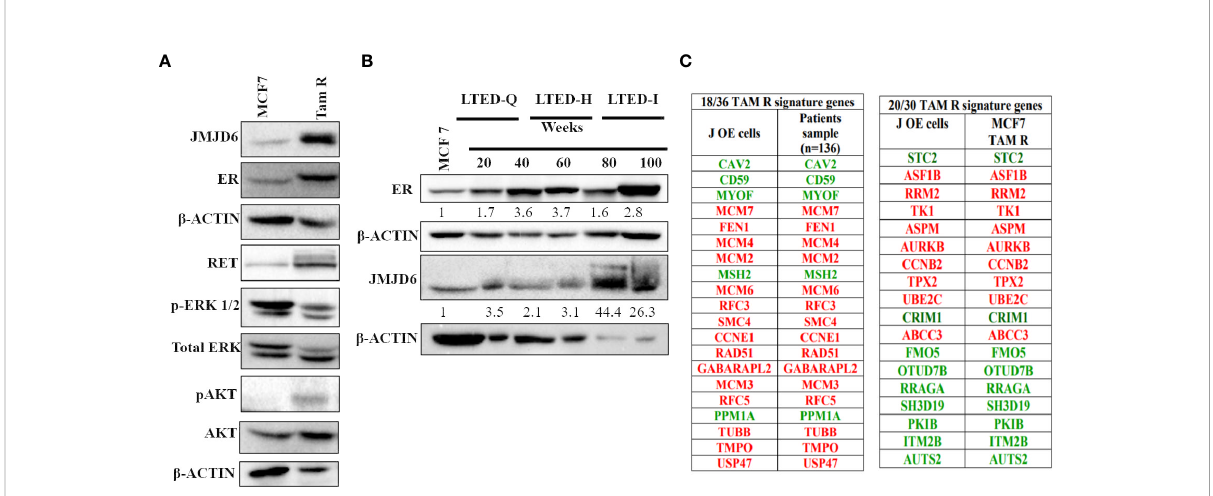
FIGURE 6 JMJD6 expression in MCF7 derived models of tamoxifen resistance (TAM R and LTED cells). (A) Characterization of TAM R cells - Western blot analysis of JMJD6, RET, ERK and AKT with b -Actin serving as an internal control to demonstrate equal loading of proteins. (B) JMJD6 protein expression determined by western blot of LTED cells at different weeks following E 2 deprivation. (C) Overlap between DEGs in JOE cells and tamoxifen resistance signature genes obtained from published literature. Genes colored red are highly expressed and those colored green have lower expression in Tam resistant